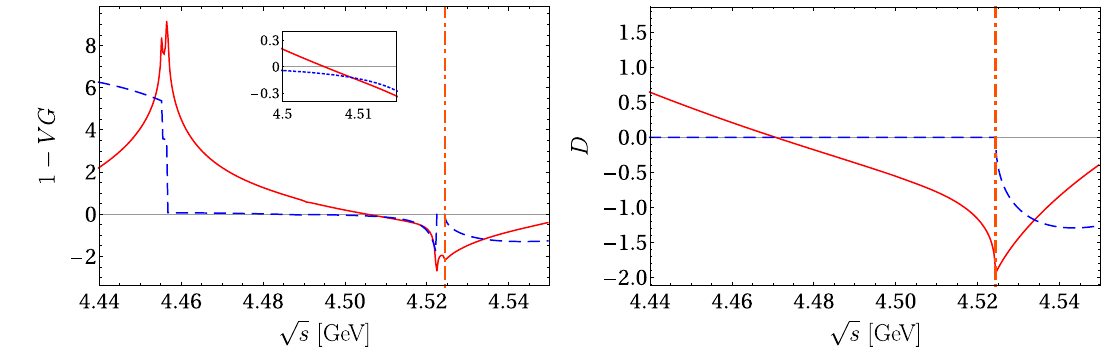
Fig. 2 ( 1 − VG ) (left panel) and D (right panel) in the physical sheet for the S -wave D ∗ (cid:2) ∗ c system with ( I , J ) = ( 1 / 2 , 5 / 2 ) (real part: solid curve, imaginary part: dashed curve). The cutoff is (cid:4) = 0 . 7GeV. The corresponding threshold is represented by the orange dash-dotted line